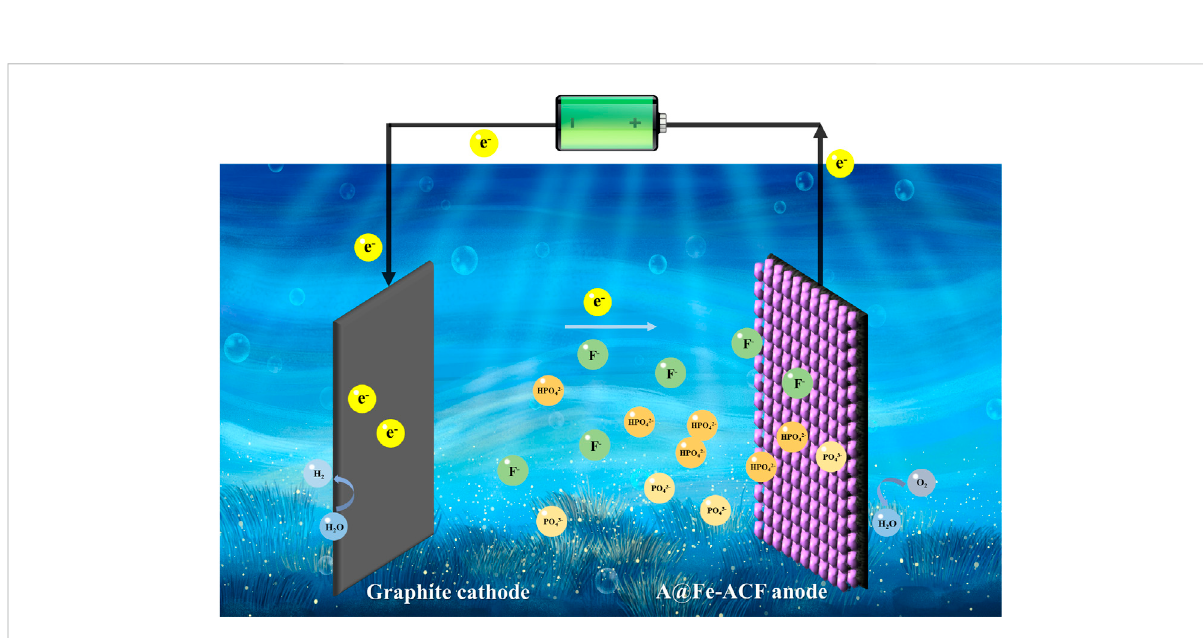
The reaction mechanism of phosphorus and fl uoride removal through